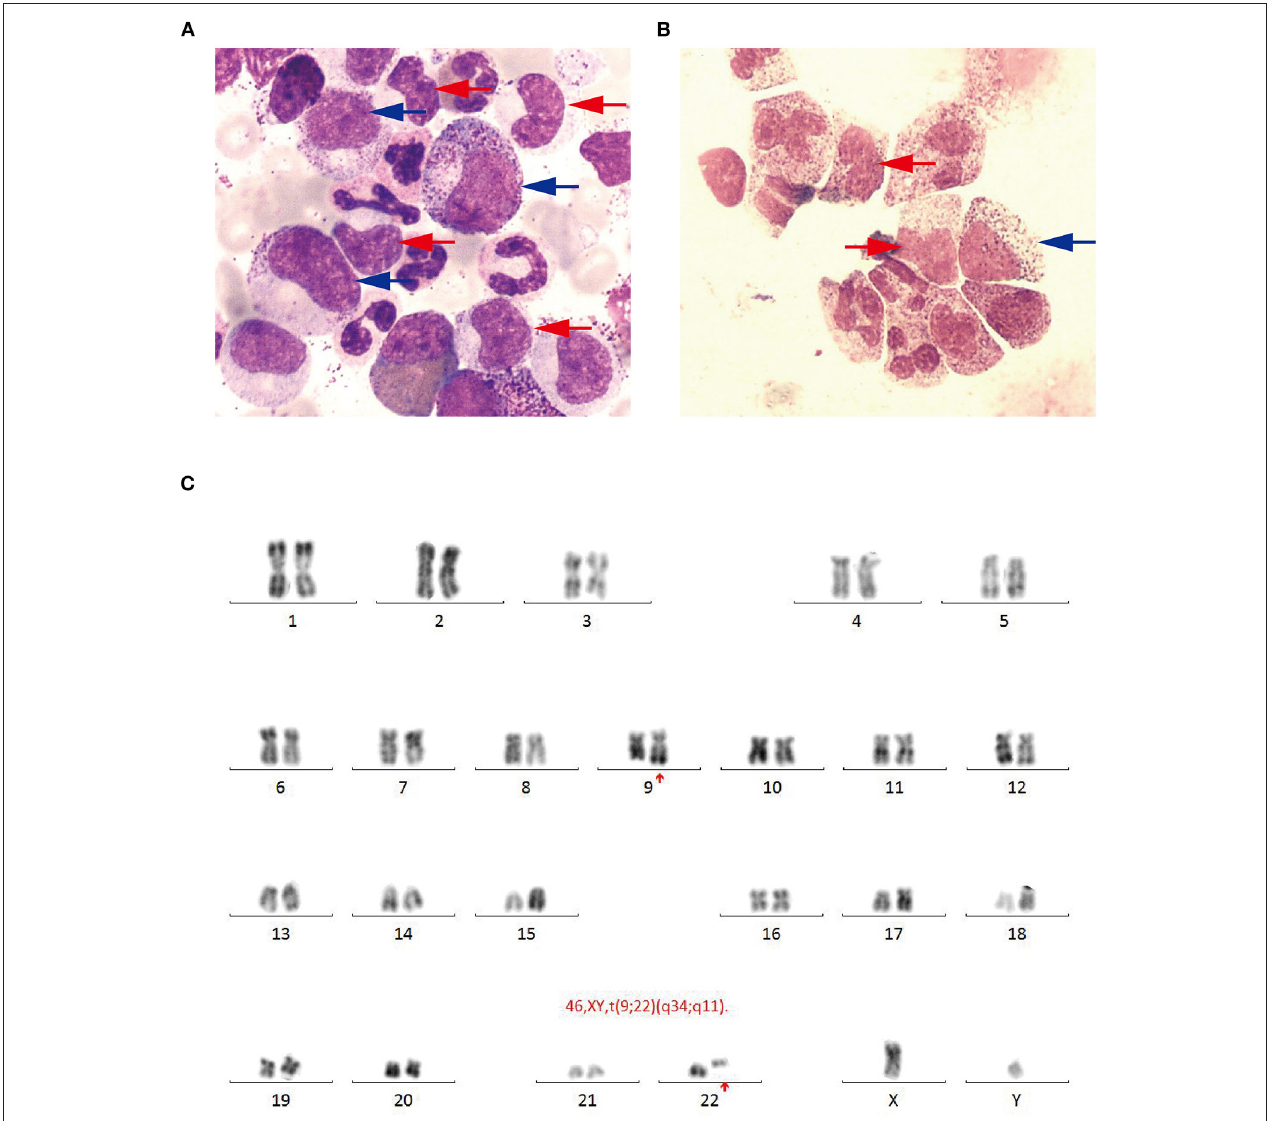
FIGURE 2 | (A) Bone marrow smear (Wright-Giemsa, × 1,000) revealing active proliferation of granulocyte series, mainly metamyelocytes (blue arrow) and myelocytes (red arrow). (B) Cerebrospinal fluid smear (Wright-Giemsa, × 1,000) revealing abnormal granulocyte series, mainly metamyelocytes and (blue arrow) myelocytes (red arrow). (C) Chromosomal analysis revealing a Philadelphia translocation t